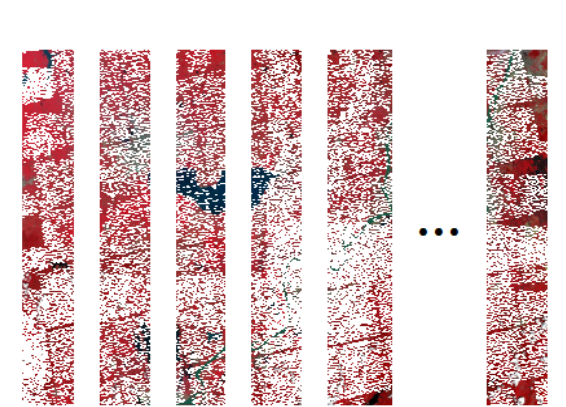
Figure 6. The GCPs are divided into several groups based on the x-coordinates. A white dot represents a GCP.